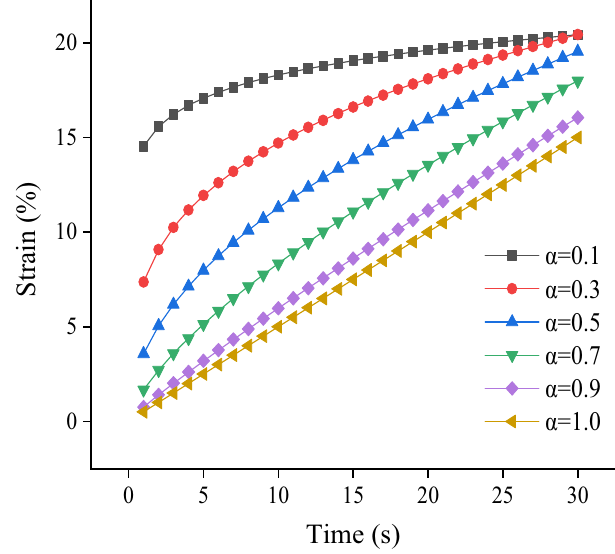
Figure 6. Strain–time curves of Abel dashpot with different